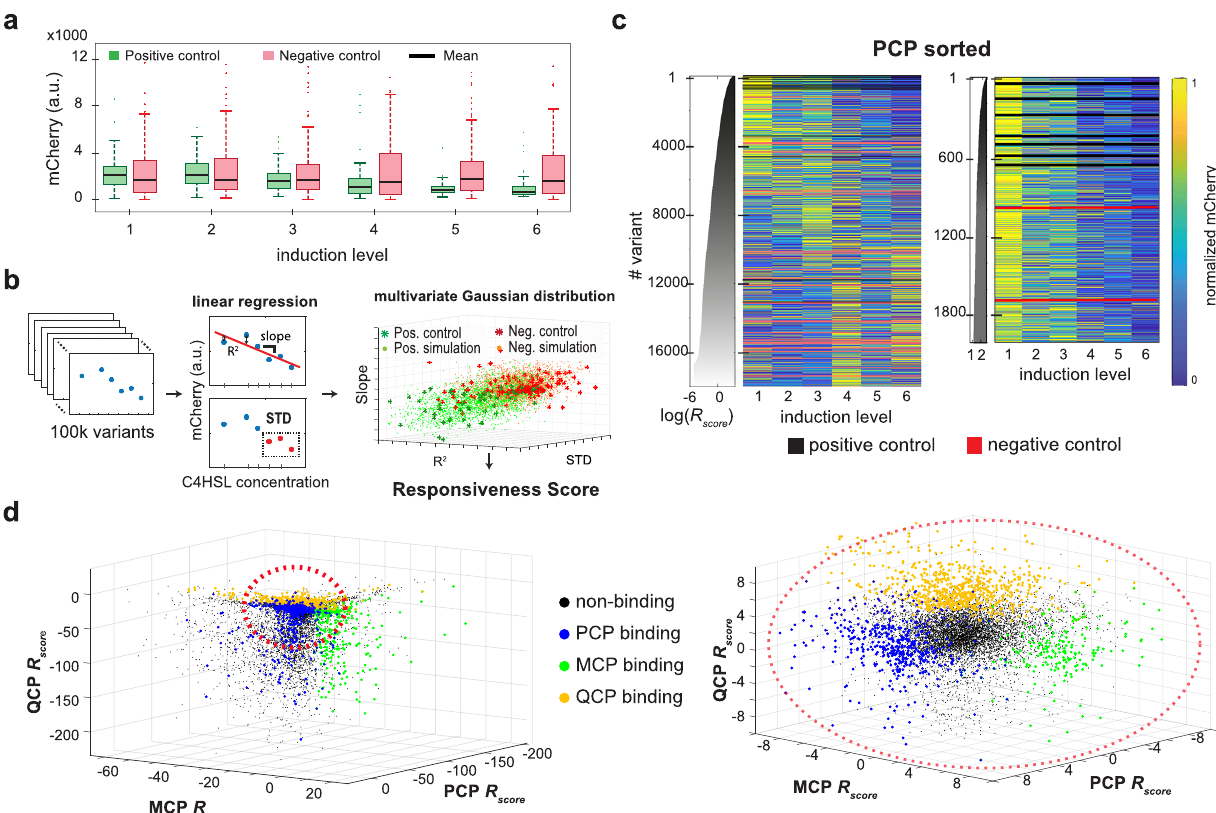
Fig. 2 Responsiveness analysis and results. a Boxplots of mCherry levels for the positive (green) and negative (red) control variants for each of the six induction levels for PCP-GFP, based on 75 different variants for positive control and 187 different variants for negative control. On each box, the central mark indicates the median, and the bottom and top edges of the box indicate the 25th and 75th percentiles, respectively. The value for ‘ Whisker ’ corresponds to approximately ±2.7 STD (standard deviation) and 99.3 percent coverage and extends to the adjacent value, which is the most extreme data value that is not an outlier. The outliers are plotted individually as plus signs. b Schema for responsiveness score ( R score ) analysis. (Left and middle) Linear regression was conducted for each of the 100k variants, and two parameters were extracted: slope and goodness of fi t ( R 2 ). The third parameter is the standard deviation (STD) of the fl uorescence values at the three highest induction levels. (Right) Location of the positive control (dark green stars) and negative control (red stars) in the 3D-space spanned by the three parameters. Both populations (positive and negative) were fi tted to 3D-Gaussians, and simulated data points were sampled from their probability density functions (pdfs) (orange for negative and green for positive). Based on these pdfs the R score was calculated. c (Left) Heatmap of normalized mCherry expression for the ~20k variants with PCP. Variants are sorted by are positive and negative controls, respectively, and the gray graph is the R score as a function of variant. (Right) “ Zoom-in ” on the 2,000 top- R score binding sites for PCP. d (Left) 3D-representation of the R score for every binding site in the library and all RBPs. Responsive binding sites, i.e., sites with R score > 3.5, are colored blue for PCP, green for MCP, and yellow for QCP. (Right) “ Zoom-in ” on the central highly concentrated region. Source data are provided as a Source data fi le. Altogether, we identi fi ed 1868, 1144, and 2624 binding sites (i.e., R score > 3.5) for PCP, MCP, and QCP, respectively. In addition, there were an additional 3736, 1460, and 4682 “ non-classi fi ed ” binding sites (i.e., 0 < R score < 3.5) for PCP, MCP, and QCP, respectively, while the rest were determined to be non-binding ( R score <